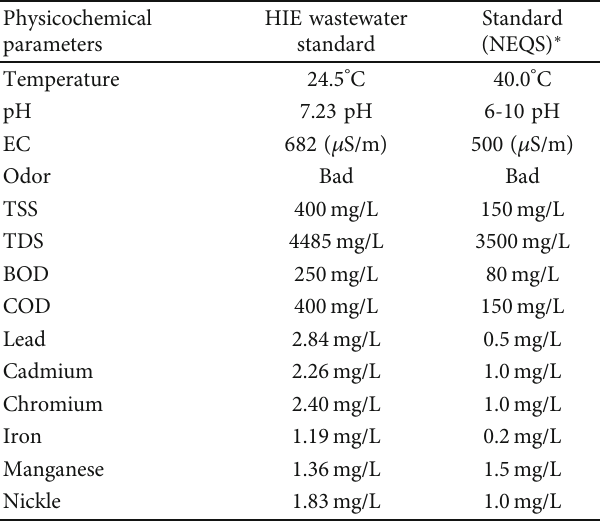
Hayatabad industrial estate (HIE). The water was analyzed to evaluate the pollution load and heavy metal